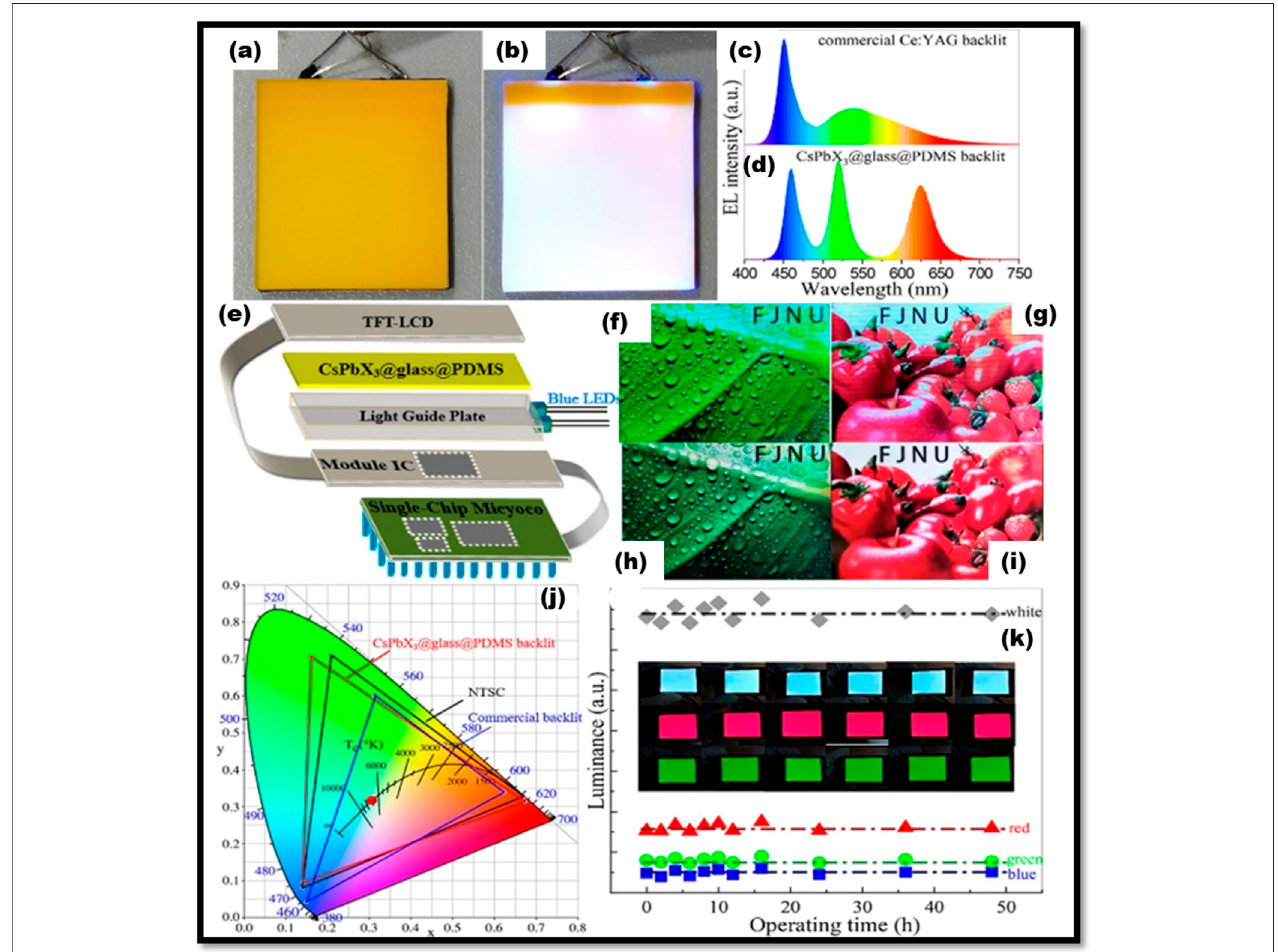
FIGURE 13 | Demonstrations ofthe CsPbX 3 @glass@PDMS fi lm-based backlight unit with the size of 4 cm × 6 cm. (A) Under daylight and (B) under 3.3 V applied voltage.ELspectraofwhitebacklightunitsusingblueLEDchipswith (C) Ce:YAGyellowphosphorand (D) CsPbX 3 @glass@PDMS fi lm. (E) SchematicillustrationofLCD device structure using theas-preparedbacklight unit. Display performance ofthe LCD screenwith the (F,G) commercial backlight unit and (H,I) CsPbX 3 @glass@PDMS fi lmbacklightunit. (J) Colorgamutofthecommercialscreen(blueline),theCsPbX fi lmscreen(redline),andNSTC1953standard(blackline)inthe 3 @glass@PDMS CIE diagram. (K) Variation of luminance of LCD devices with continuous operating times up to 48 h. Insets are the corresponding working green, red, and white LCD devices (Lin et al., 2021)